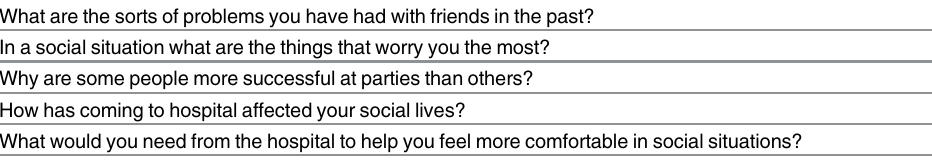
Table 2. Semi-structured questions developed for the focus groups. What are the sorts of problems you have had with friends in the past? In a social situation what are the things that worry you the most? Why are some people more successful at parties than